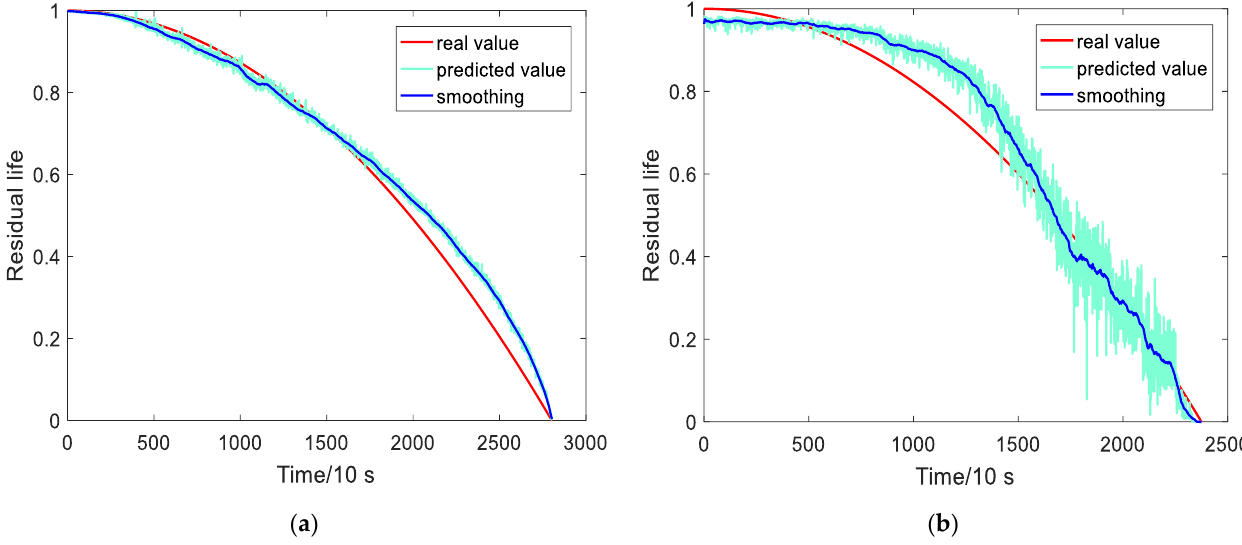
Figure 12. Prediction effect of the method in this paper on bearing 1 − 1 and 1 − 3. ( a ) Prediction effect on bearing 1 − 1; ( b ) prediction effect on bearing 1 − 3.